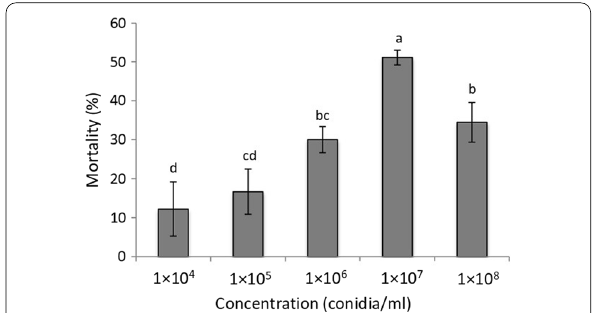
Fig. 6 Optimization of conidial concentrations of Metarhizium based on mortality percentage of Oryctes rhinoceros larvae at day 9. Different lowercase letters denote significant differences (ANOVA, Tukey’s test, P 0.05) ≤